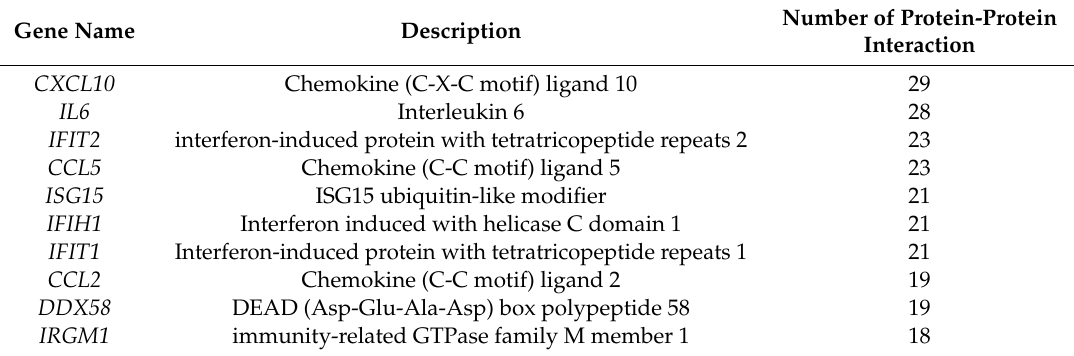
Table 4. Summary of top 10 key DEGs based on protein-protein interaction